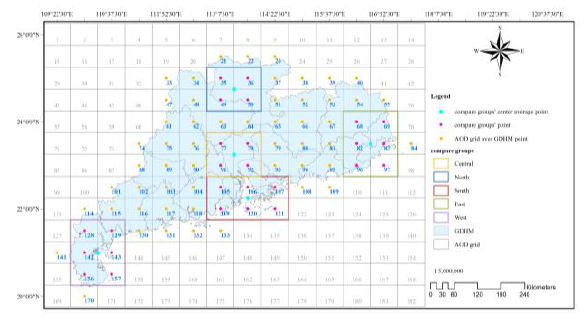
Figure 1. Map showing the 21 Cities of Guangdong province and two Special Administrative Regions Hong Kong and Macau (GDHM), the clipped grids area from MERRA-2 M2IMNXGAS 5.12.4, the groups of grids for comparison, the map is produced by Kuang using ArcMap 10.5.